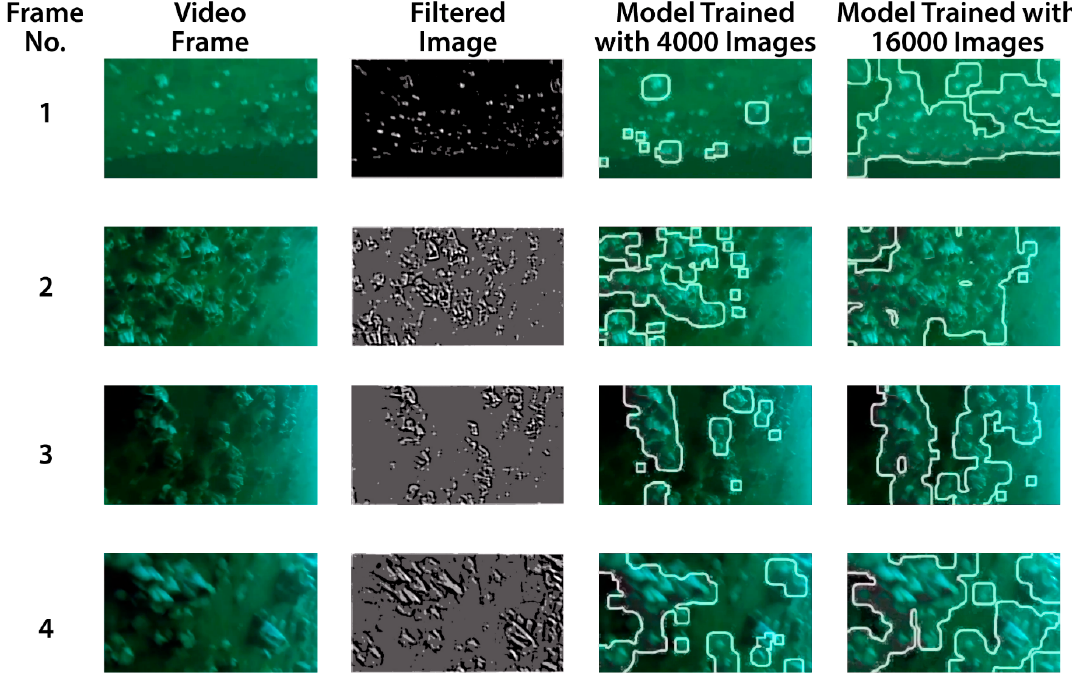
Figure 9. Barnacles detected on ship hull with CNN trained on 4000 images and 16,000 images respectively.